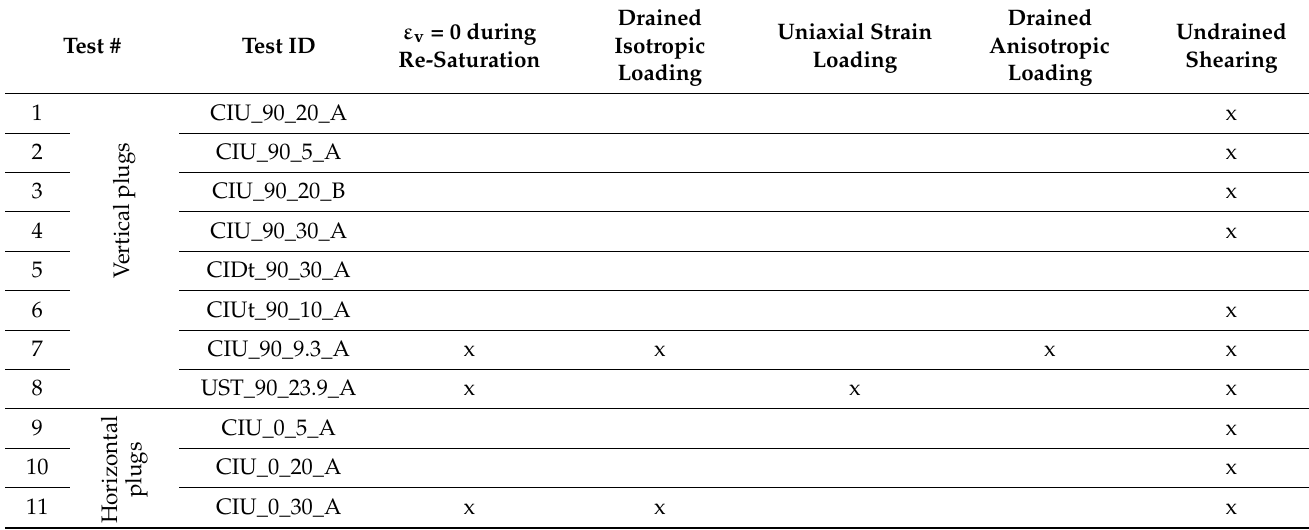
Table 3. The matrix of the triaxial tests and the measurements made. Test ID consists of test type_sample axis orientation with respect to rock layering_effective mean consolidation stress_letter to separate tests with other identical